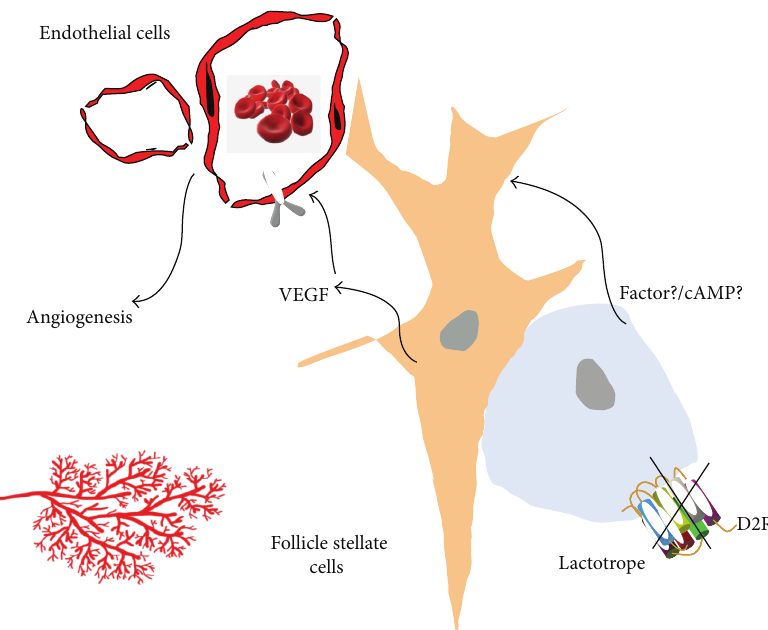
Figure 1: Disruption of the D2R from lactotropes induces paracrine VEGF secretion from follicle stellate cells. VEGF acts on VEGFR2 receptors on endothelial cells to induce pituitary angiogenesis.